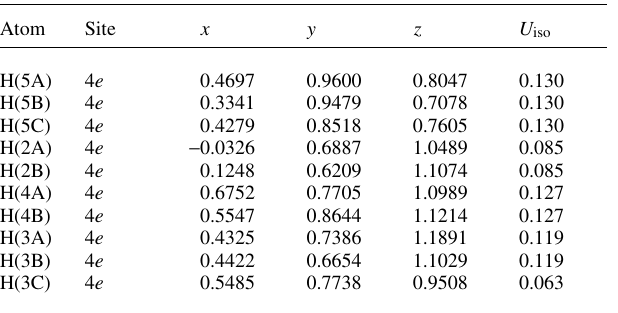
Table 2. Atomic coordinates and displacement parameters (in Å 2 )